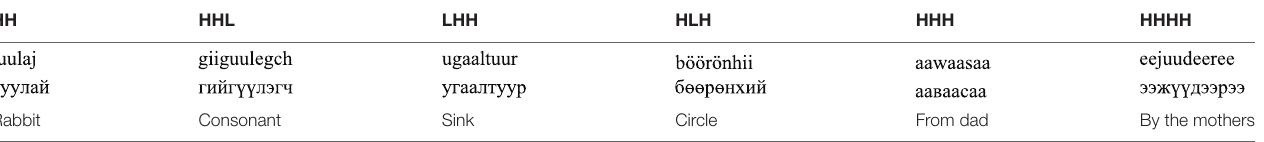
TABLE 1 | Example stimuli: words with multiple heavy syllables. HH HHL LHH HLH HHH HHHH